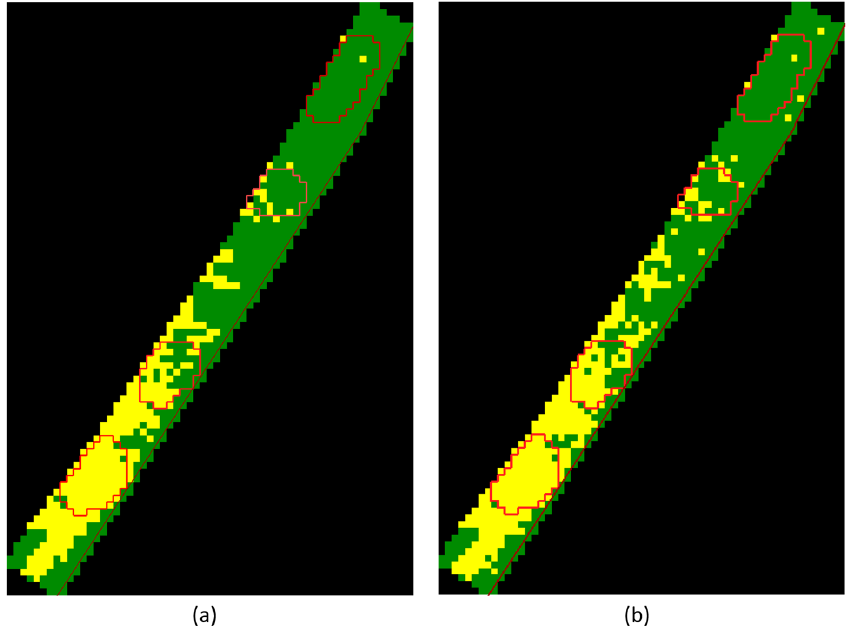
Figure 8. ( a ) Support vector machine classification; and ( b ) maximum likelihood classification.